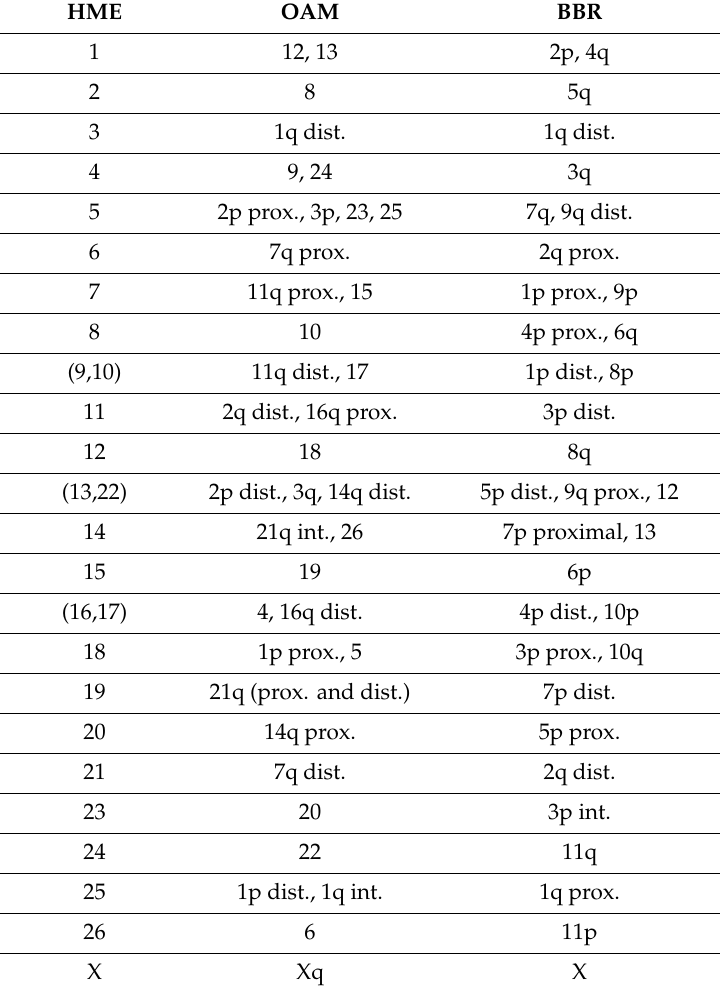
Table 3. FISH signals detected for Oxymycterus amazonicus (OAM; 2n = 54, FN = 64) and Blarinomys breviceps (BBR; 2n = 28, FN = 50), as assessed based on hybridization with Hylaeamys megacephalus (HME) whole-chromosome probes